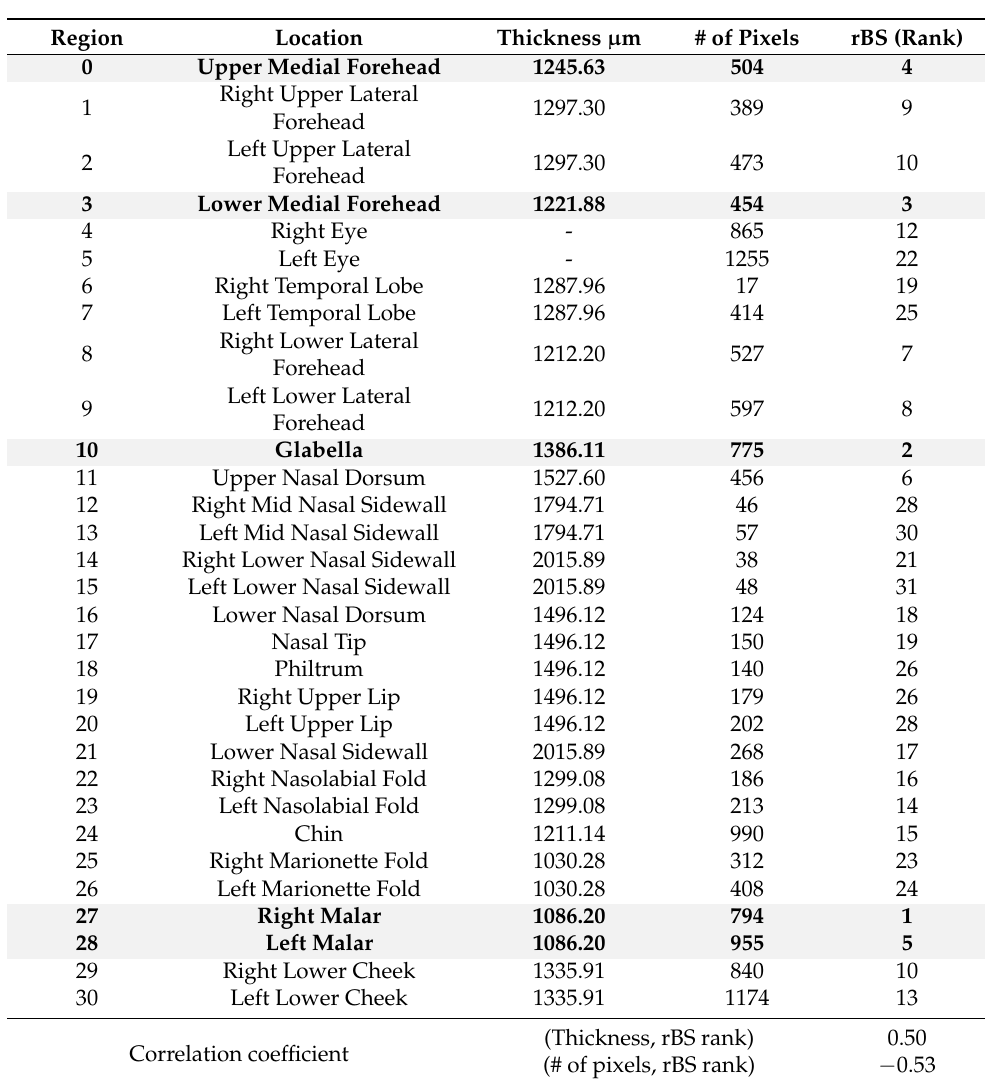
Table 7. Thickness and # of pixels at each region.